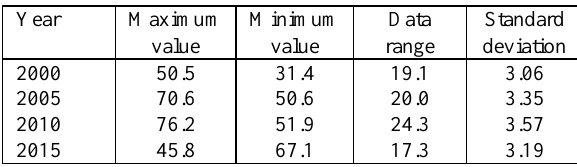
Table 3. Details of PM2.5 exposure in